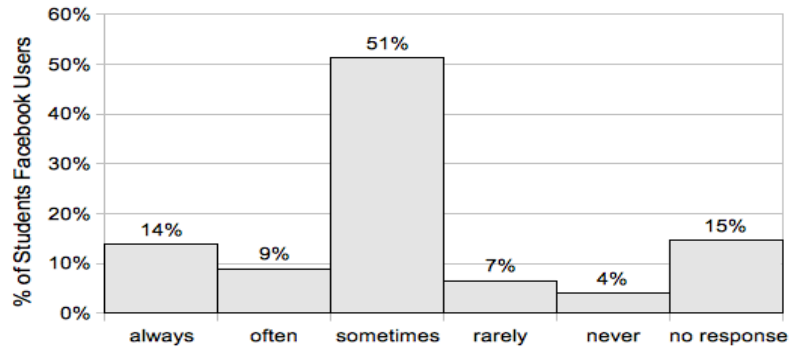
Figure 12. Facebook search option feature.